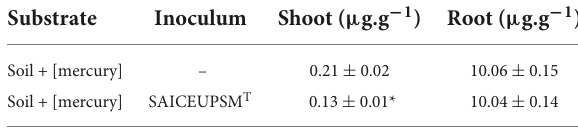
TABLE 5 Mercury accumulation in plant, tested in soils with high mercury